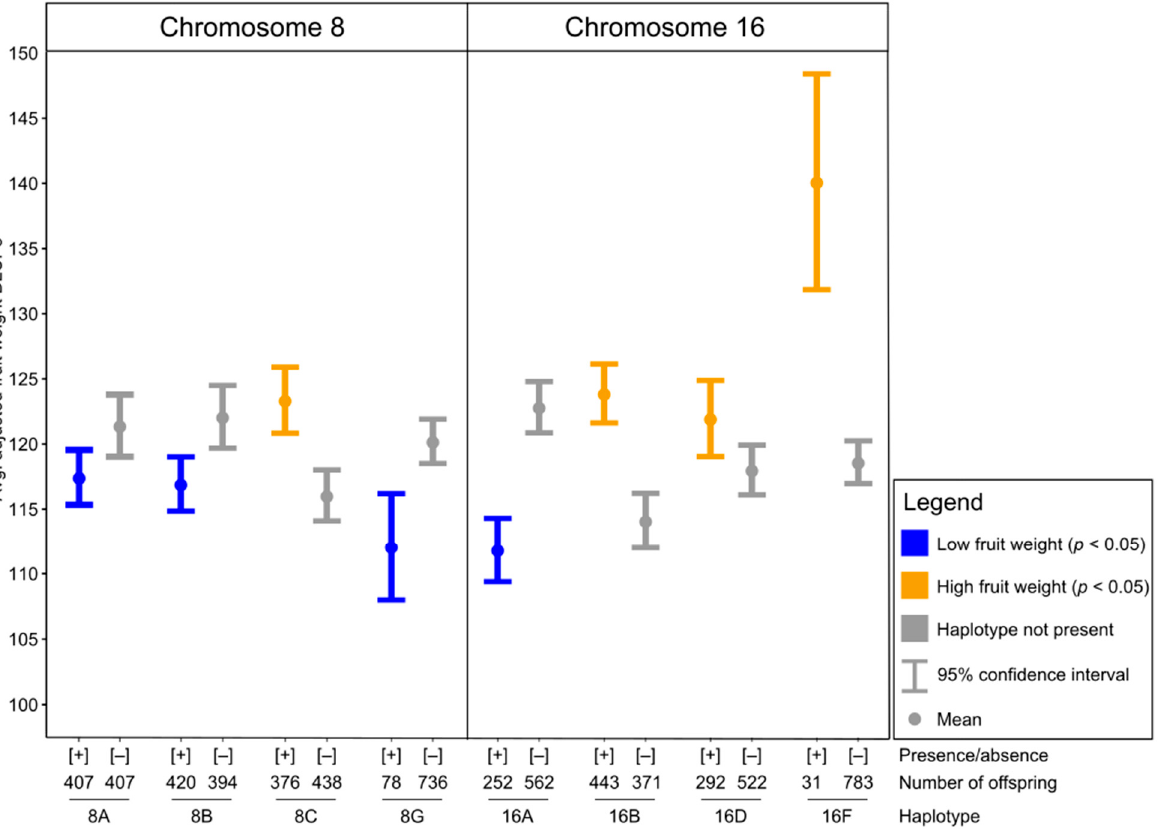
Figure 1. Means and 95% confidence intervals of adjusted fruit weight best linear unbiased predic- tions (BLUPs) across years for 814 offspring with and without significant haplotypes at QTLs on chromosomes 8 and 16. For each haplotype, one-way analysis of variance was used to determine if the presence of a given haplotype had a significant effect ( p < 0.05) on fruit